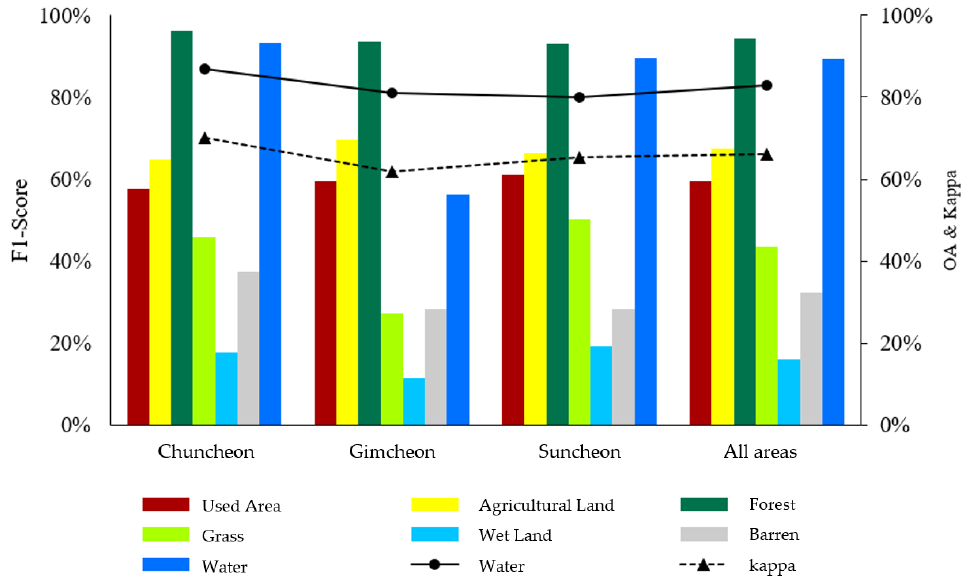
Figure 6. Evaluation of consistency of land cover categories in deep learning ‐ based land cover map.